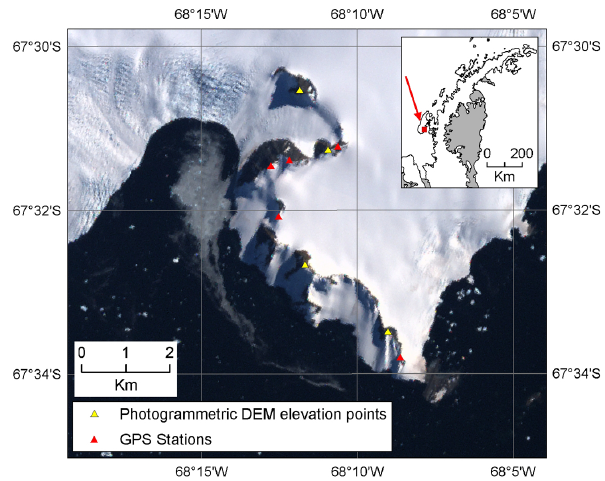
Figure 9. A map of the sample region Ryder Bay on Adelaide Is- land (location is shown on inset), displaying the location of GPS points and elevations derived from the high-accuracy photogram- metric DEM.